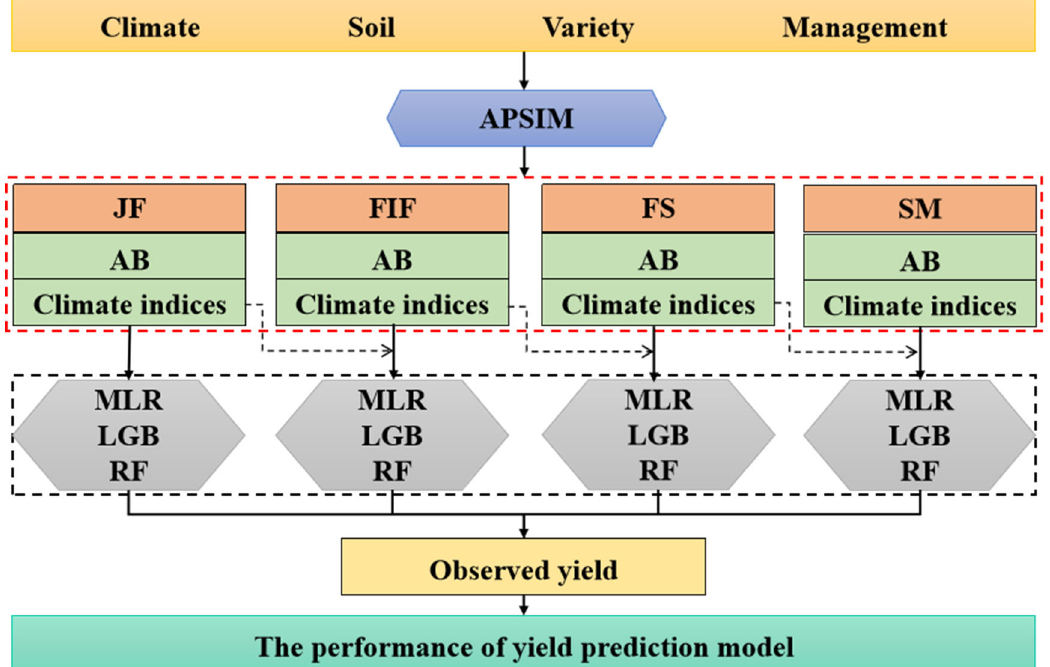
Figure 2. The diagram for the procedures used in this study, where JF, FIF, FS, and SM were the periods from the end of the juvenile stage to floral initiation, from floral initiation to flowering, from flowering to the start of grain filling, and from the start of grain filling to the milky stage, respectively. AB was accumulated biomass; MLR, LGB, and RF the multiple linear regression, light gradient boosting machine, and random forest, respectively.